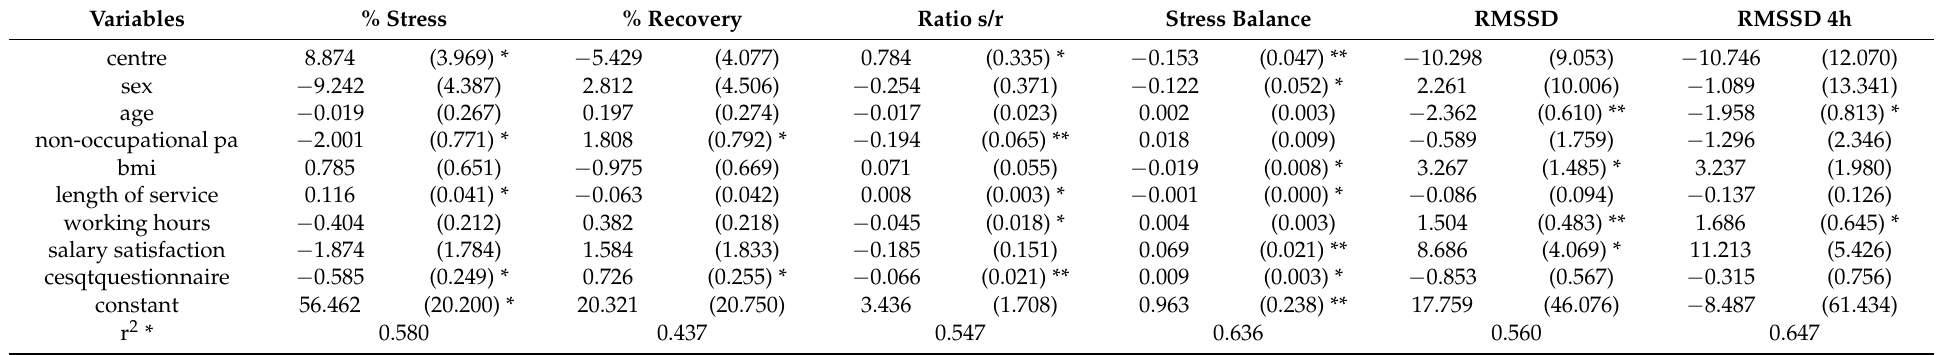
Table 4. Multiple regression analysis of the centre variable, physical variables, working conditions and subjective stress on objective stress variables (standard errors in